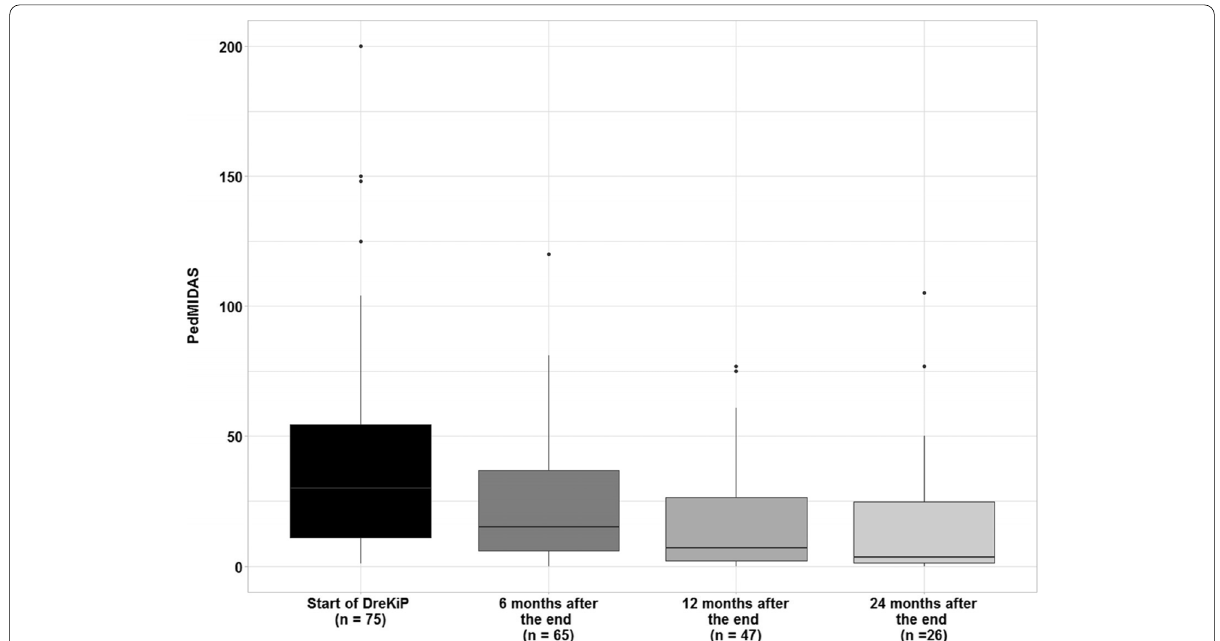
Fig. 6 PedMidas. (Median) at baseline and follow up 6, 12 and 24 months after the program “DreKiP” (stands for Dresden children and adolescent headache